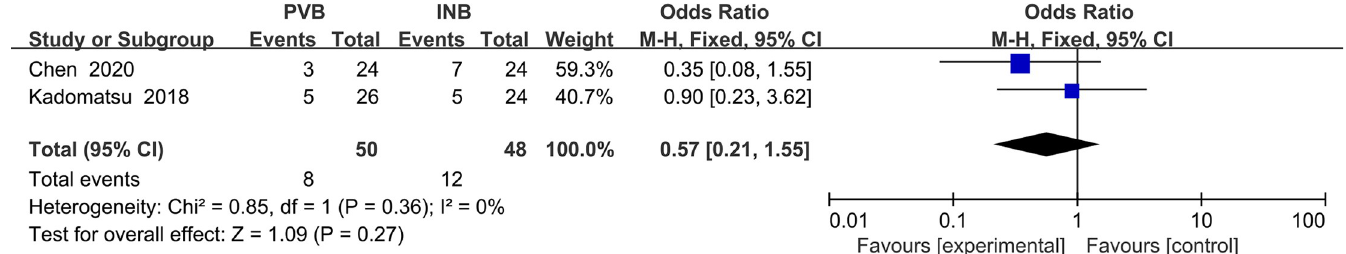
Fig 17. Forest plot of comparison: PVB VS INB. Outcome: Rates of postoperative nausea and vomiting.